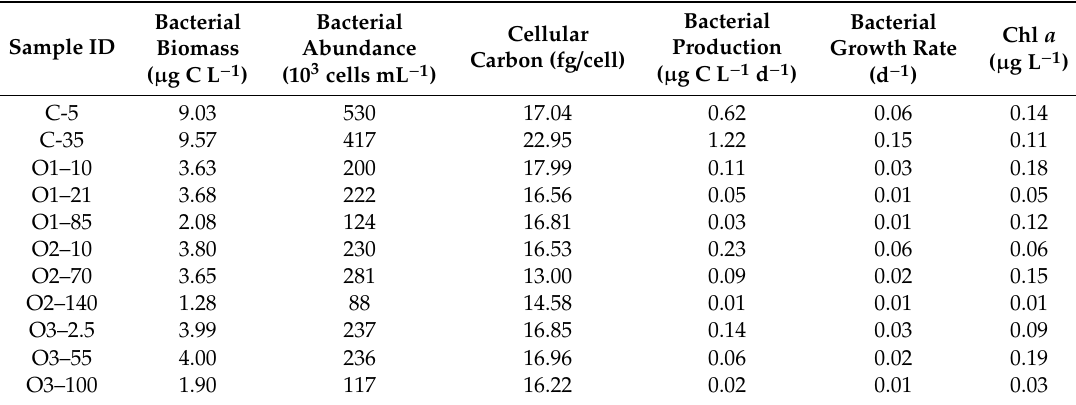
Table 2. Bacterial properties and Chl a concentrations for samples in this study.